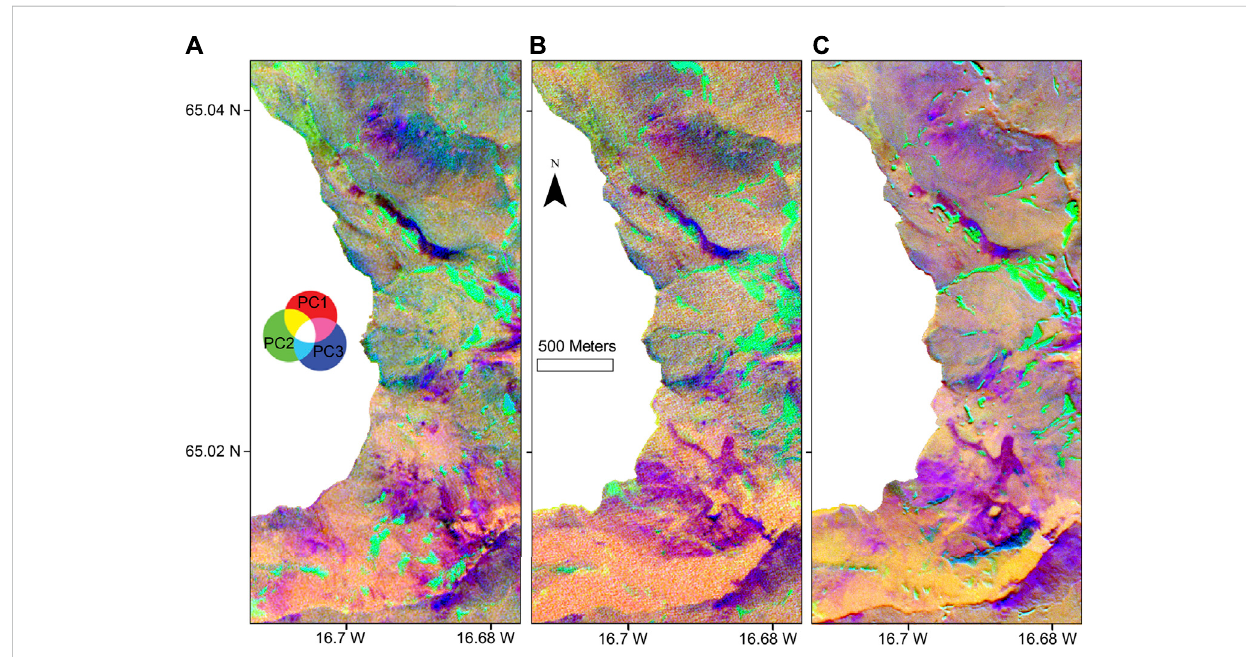
FIGURE 4 False-color RGB composite of the PCA results obtained from VHR satellite image sequence of the study area. (A) RapidEye-1 before the landslide (16 July 2012), (B) RapidEye-2 after the landslide (6 September 2014), and (C) PlanetScope just 24 days prior to our drone survey (4th of August